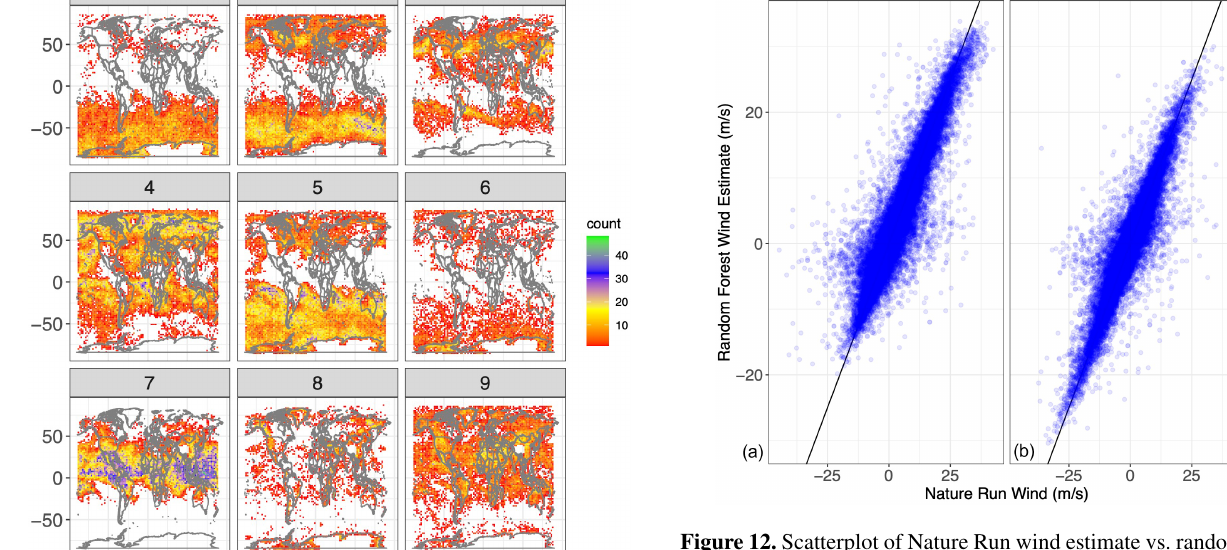
Figure 12. Scatterplot of Nature Run wind estimate vs. random for- est produced estimate. (a) u direction; (b) v